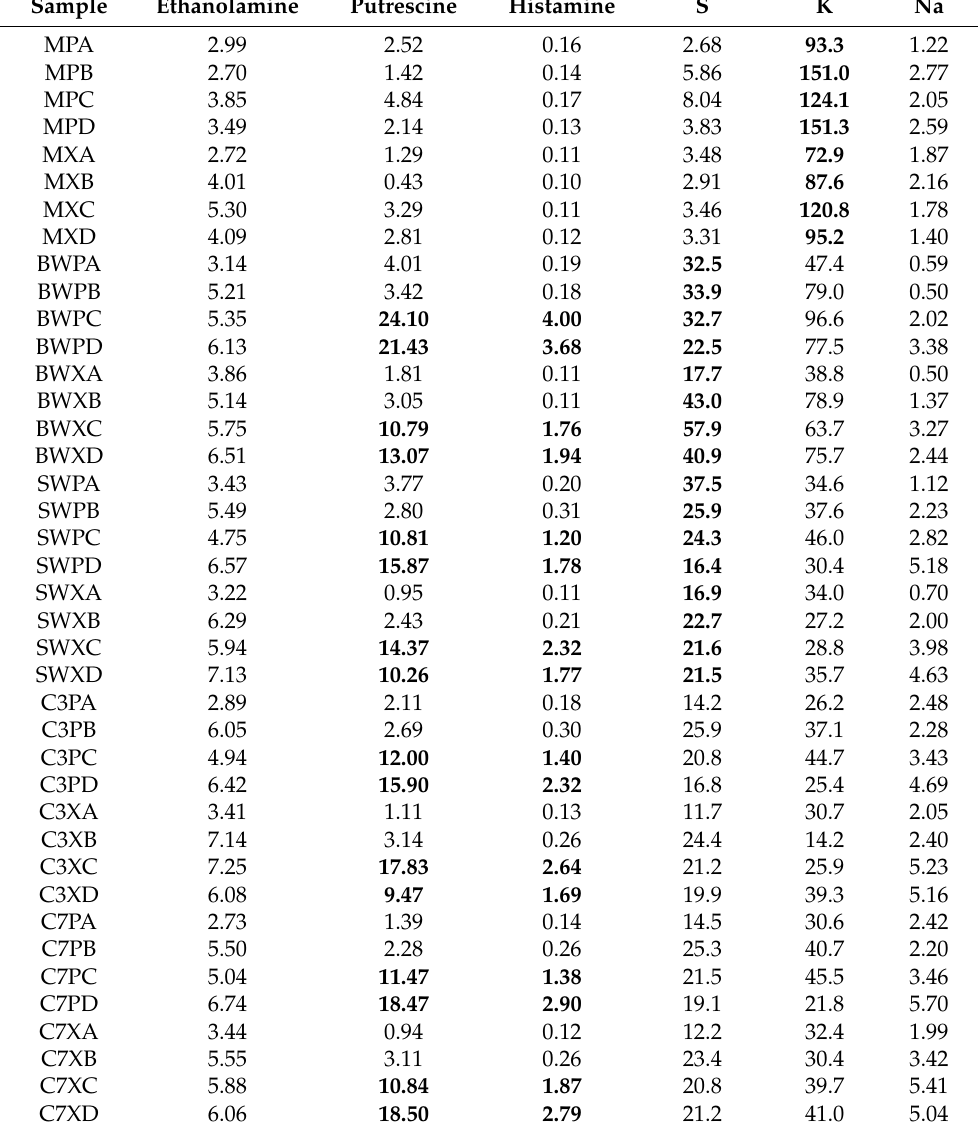
Table 3. Determination of various relevant compounds in the different samples. Concentrations are expressed in mg L − 1 . Bold numbers denote samples with higher values.